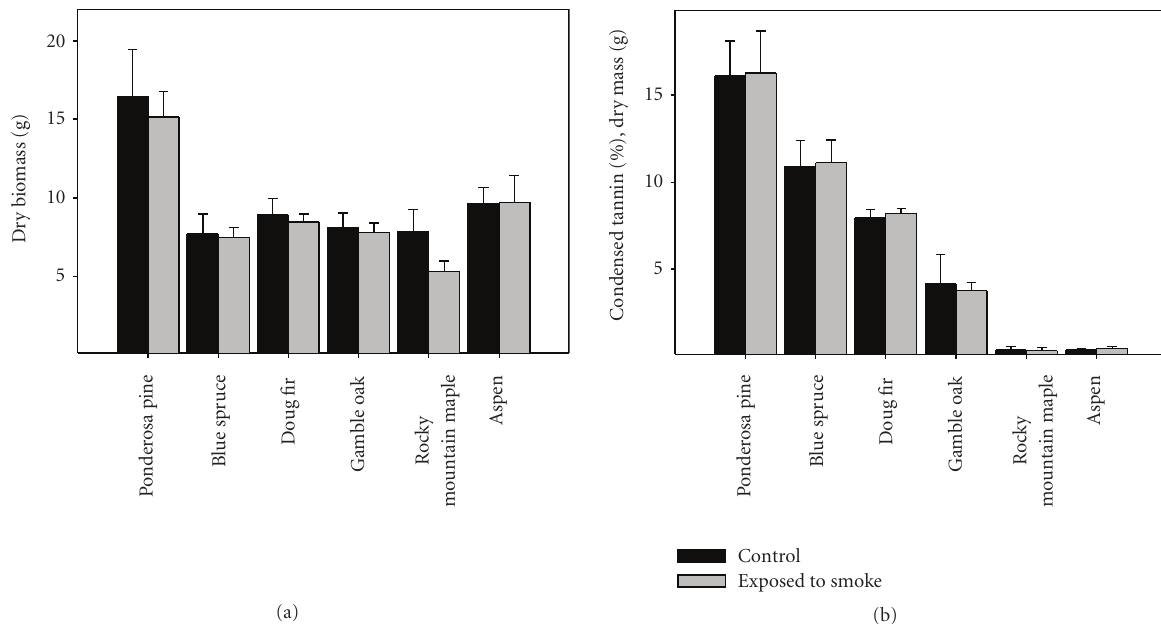
Figure 3: Comparisons of biomass and condensed tannins in smoke-exposed samples and controls. There were no significant di ff erences between treatments of any